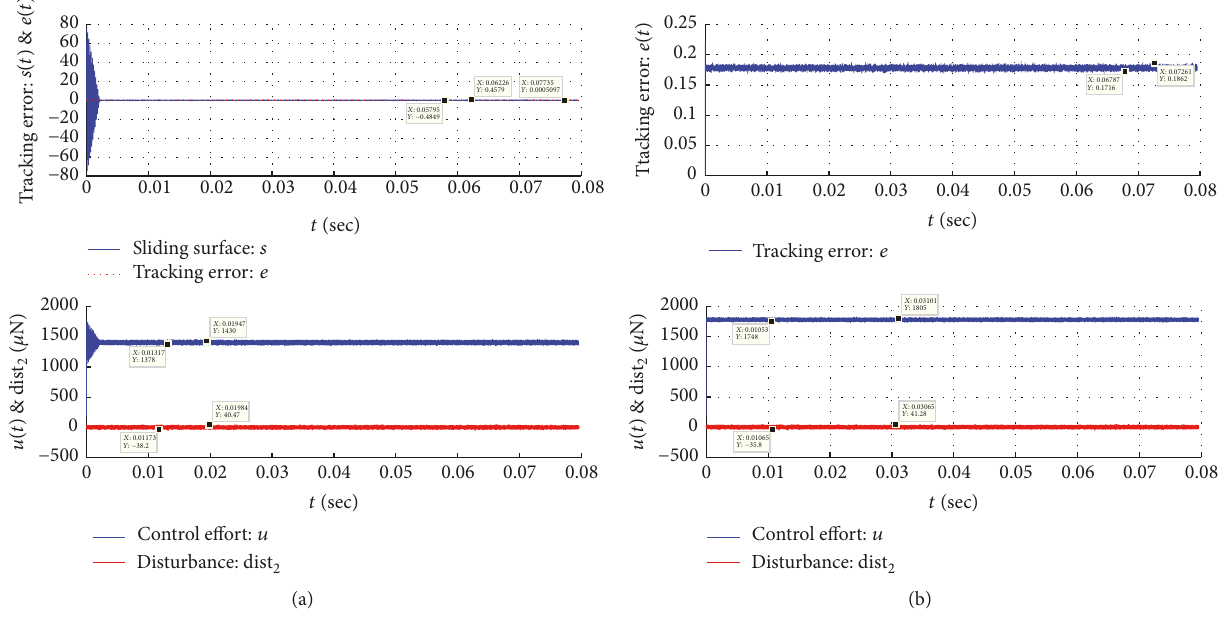
Figure 6: Tracking performance comparison between adaptive sliding mode controller and pole-placement state feedback one, both being susceptible to various malfunctioning effects: (a) tracking performance of the adaptive sliding mode controller in presence of parameter uncertaintyandrandomdisturbance;(b)trackingperformanceofthepole-placementstatefeedbackoneinpresenceofparameteruncertainty and random